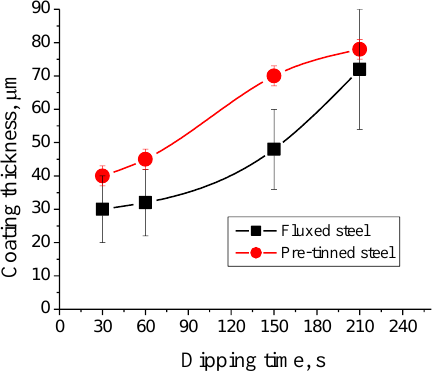
Figure 4. Effect of dipping time on thickness of Al alloy surface layer of fluxed and pre-tinned